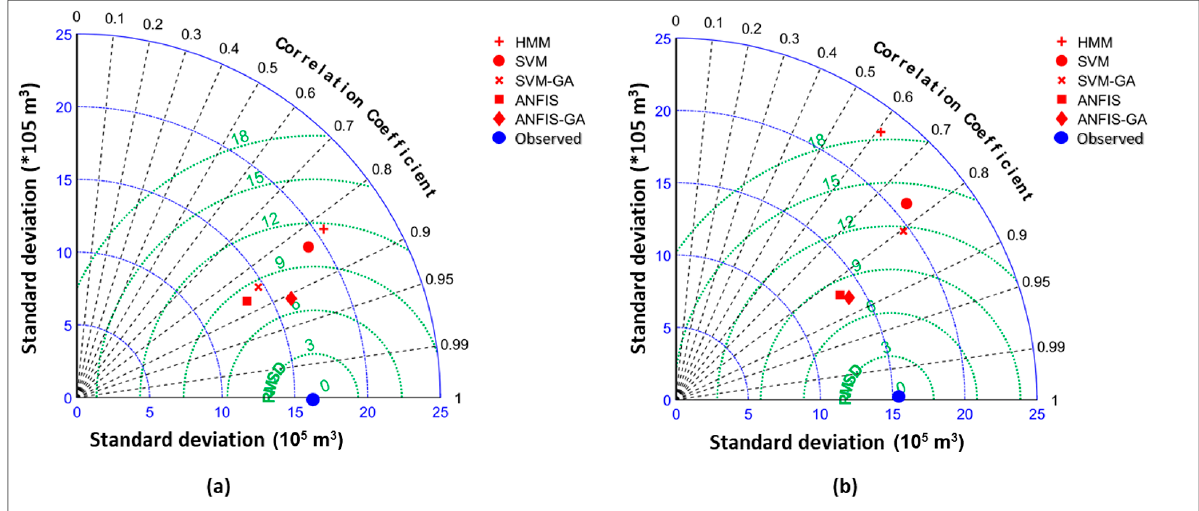
Figure 11. Taylor diagram for HMM, SVM, SVM-GA, ANFIS, and ANFIS-GA compared to the observed data. ( a ) Training ( b ) Testing.